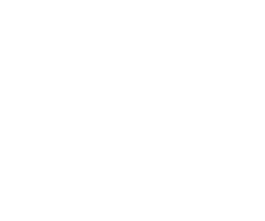
Figure 5. Diagram of an Impedance Eye Recording (IER) Lens injected in Styrene-Methyl Methac- rylate (SMMA) with thin gold layer